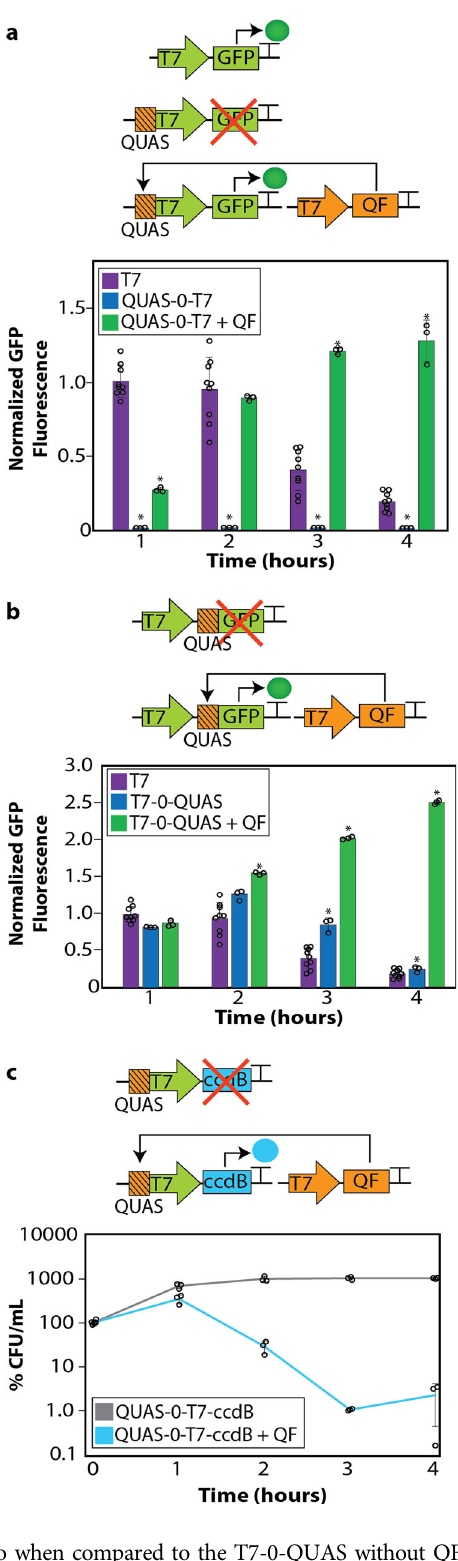
(Fig. 1c and Supplementary Fig. 3). In contrast, QF activated within 2 h of induction of T7RNAP (Fig. 1c). We conclude that placing QUAS upstream of the T7 promoter establishes a tightly regulated switch that can maintain tight off states and rapidly activates in the presence of QF.